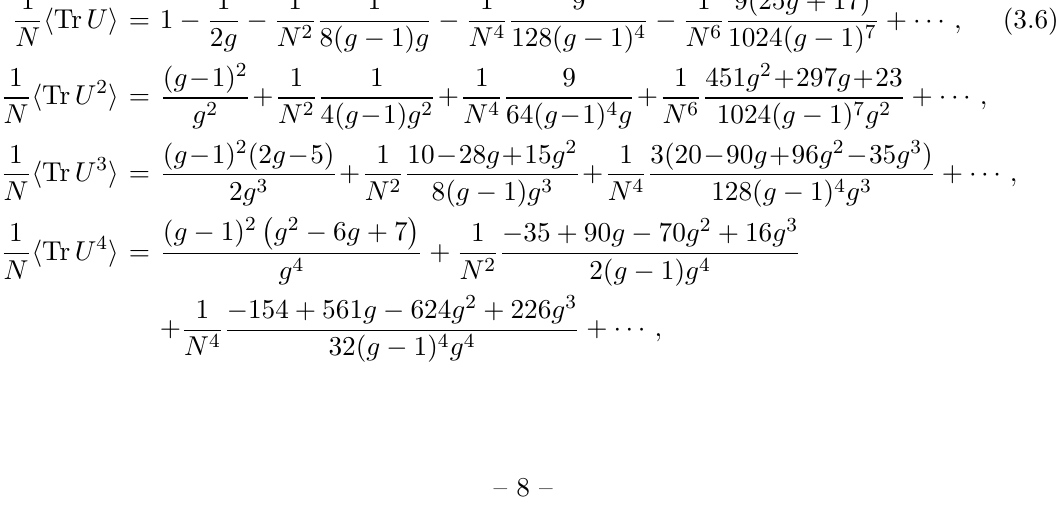
Figure 5. Plot of the expectation value of the winding Wilson loops u k = 1 The red dots are the exact values at N = 100, while solid curves represent the planar limit in (3.5).